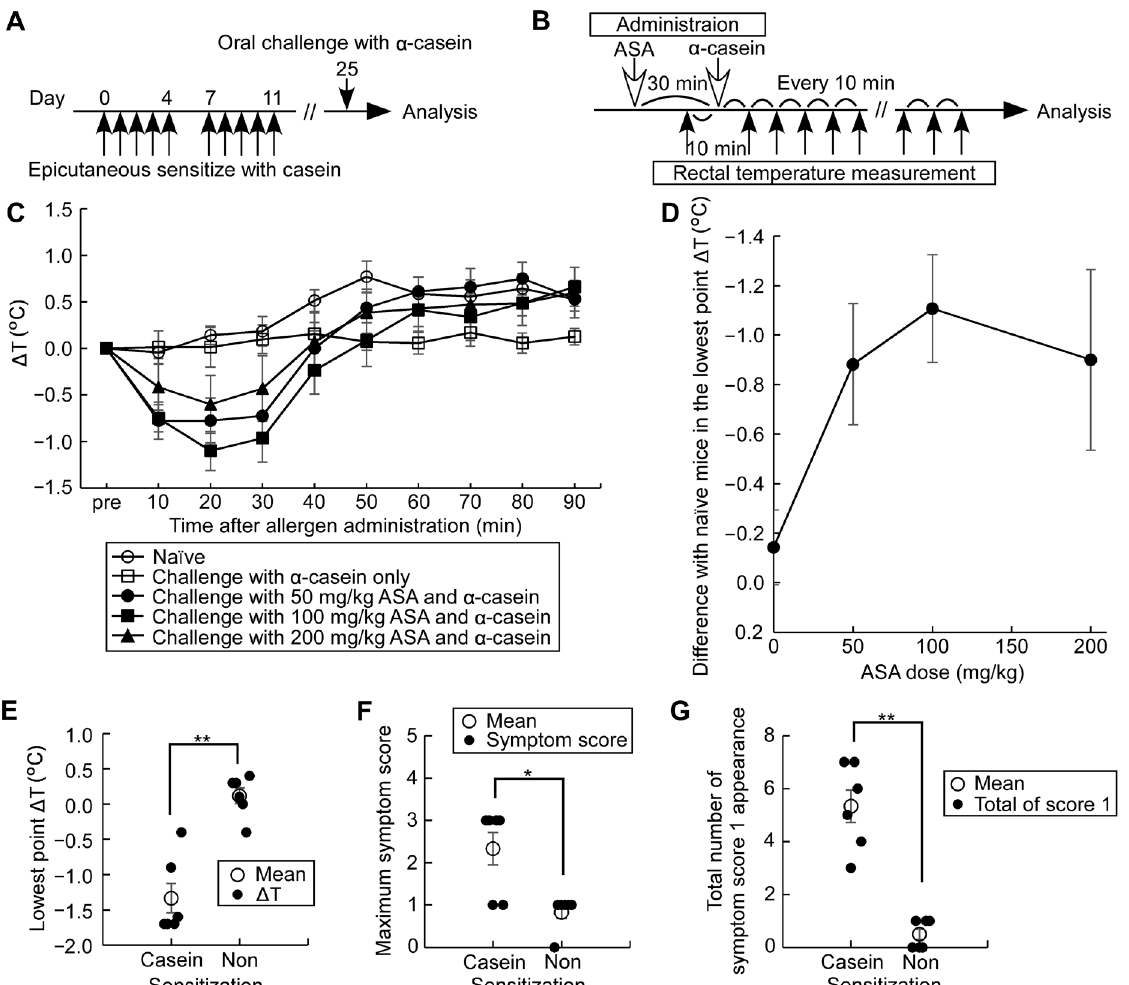
Figure 7. Design of adjuvant-free cow’s milk allergy experiments. ( A ) Experimental protocol; ( B ) Oral challenge protocol of 12 mg α -casein combined with 30 min ASA-pre-medication; ( C ) Serial